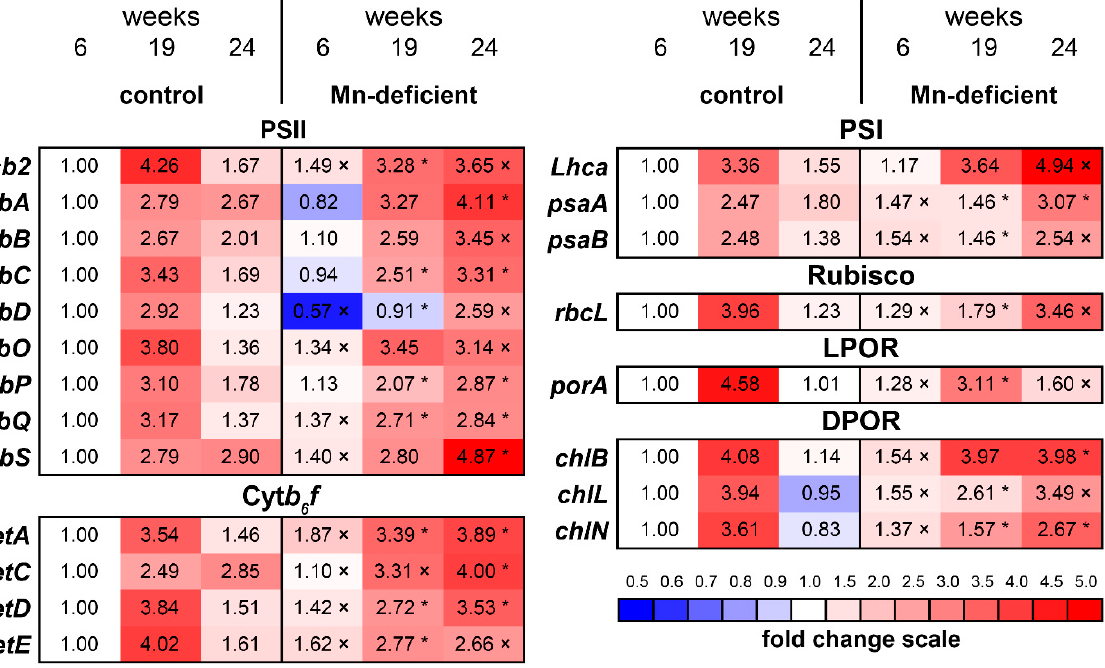
Figure 4. The transcript levels of photosynthetic genes ( Lhcb2 , psbA , psbB , psbC , psbD , psbO , psbP , psbQ , psbS , petA , petC , petD , petE , Lhca , psaA , psaB and rbcL ) and genes involved in chlorophyll biosynthesis ( porA , chlB , chlL , chlN ) in the needles of Scots pine seedlings. Asterisks (*, for Student’s t test) or multiplication signs (×, for Mann–Whitney rank sum test) denote significant differences at p < 0.05 between control and Mn-deficient plants at each separate time point.